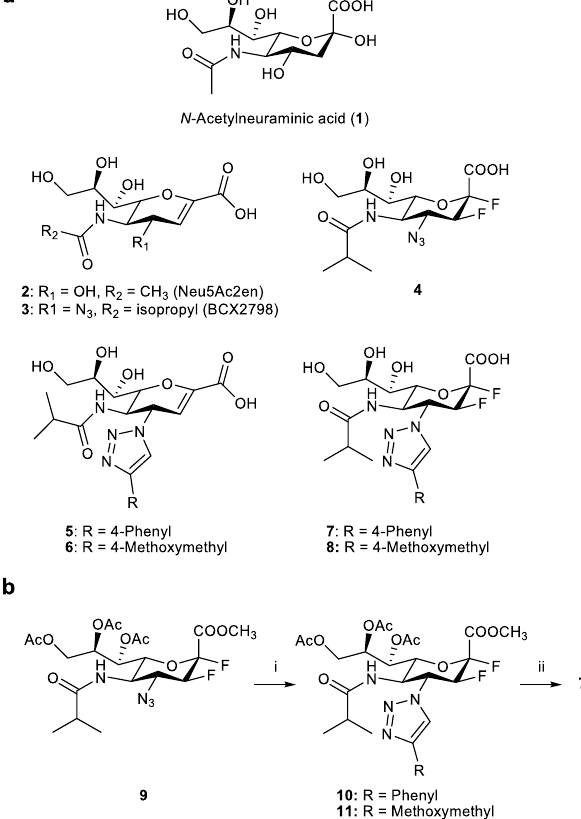
Figure 1. Structures of reference and novel inhibitors and synthetic strategy. ( a ) Structures of Neu5Ac ( 1 ), reference Neu2en hPIV-3 HN inhibitors 2, 3, 5 and 6 , the reference 2 α ,3 β -difluoro-analogue of BCX 2798 ( 4 ) and the novel 2 α ,3 β -difluoro-4-triazolo- N -acylneuraminic acid derivatives 7 and 8 . ( b ) (i) CuSO 4 , sodium ascorbate,